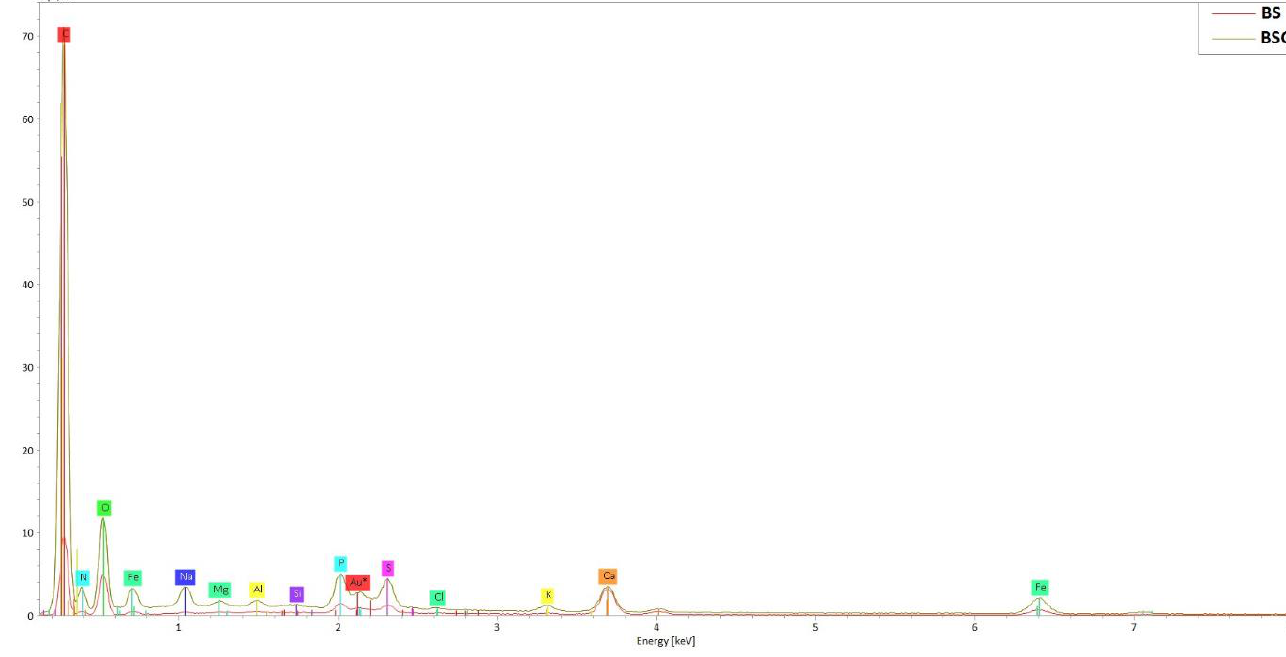
Figure 4. EDS results of Biosolid (BS) and Biosolid biochar